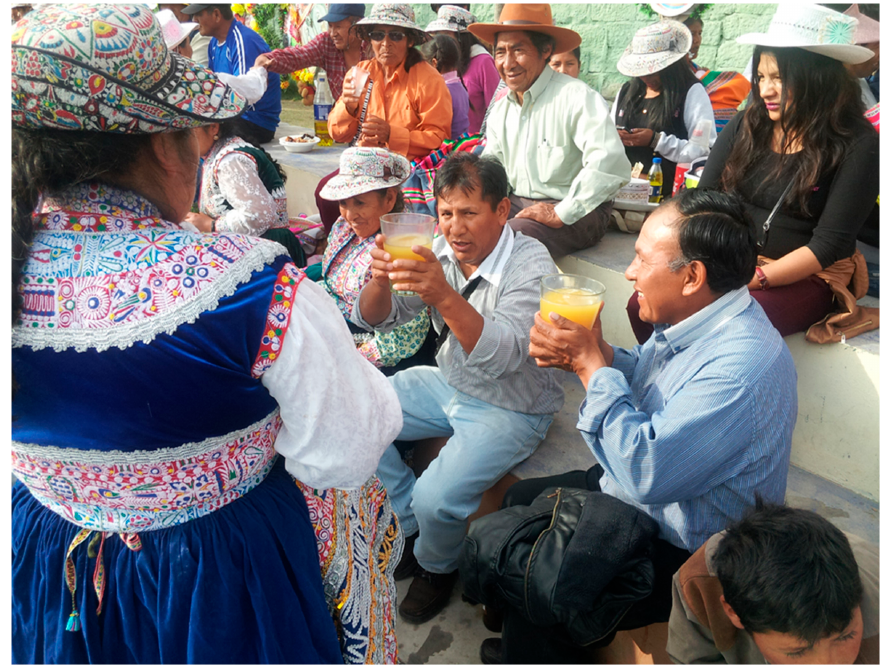
Figure 2. These migrants from the high-Andean town of Lari living in the mid-Andean city of Arequipa raise two communal glasses of homemade corn beer during Lari’s Catholic patron saint festival after ch’allando (ceremonially spilling) some onto the ground for the Pachamama and before drinking and passing the glass to the next person waiting to dance. January 2018.